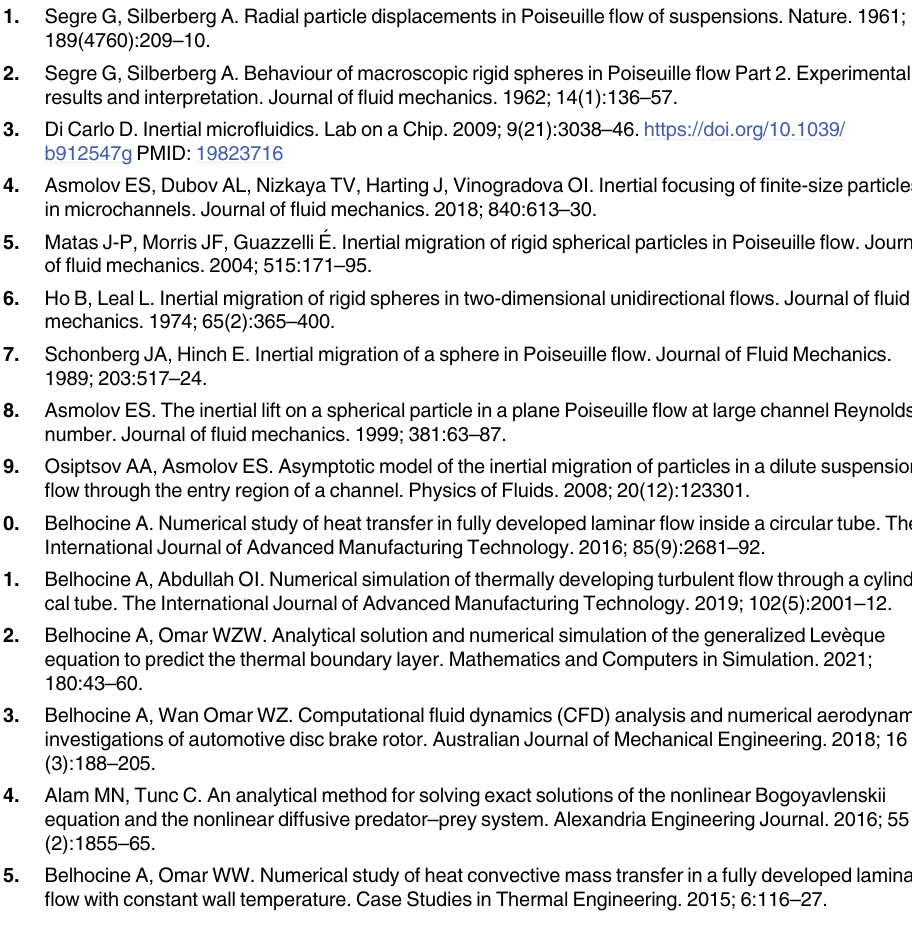
S1 Table. Average torque values of the two calculation models at different interval angles. The comparison between the standard value calculated by the two-degree-of-freedom model and the average value calculated by the steady model under different spacing